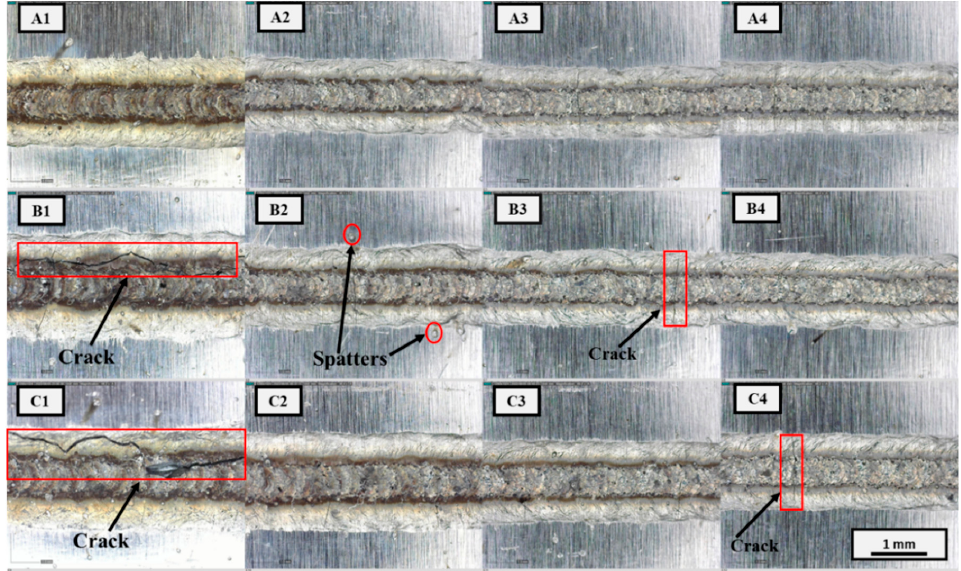
Figure 6. Optical micrographs of top weld bead: (A1) power = 1500 W, welding speed = 15 mm/s; (A2) power = 1500 W, welding speed = 20 mm/s; (A3) power = 1500 W, welding speed = 25 mm/s; (A4) power = 1500 W, welding speed = 30 mm/s.; (B1) power = 1600 W, welding speed = 15 mm/s; (B2) power = 1600 W, welding speed = 20 mm/s; (B3) power = 1600 W, welding speed = 25 mm/s; (B4) power = 1600 W, welding speed = 30 mm/s ; (C1) power = 1700 W, welding speed = 15 mm/s; (C2) power = 1700 W, welding speed = 20 mm/s; (C3) power = 1700 W, welding speed = 25 mm/s; (C4) power = 1700 W, welding speed = 30 mm/s.